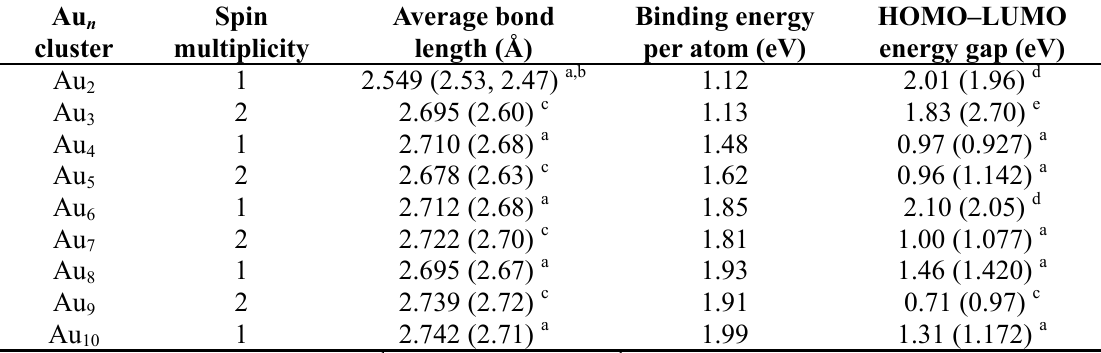
Table 1. Calculated structural parameters of Au parentheses are taken from other